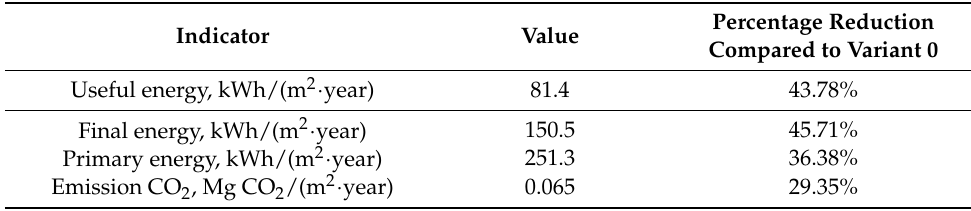
Table 9. Energy performance indicators—variant 2.